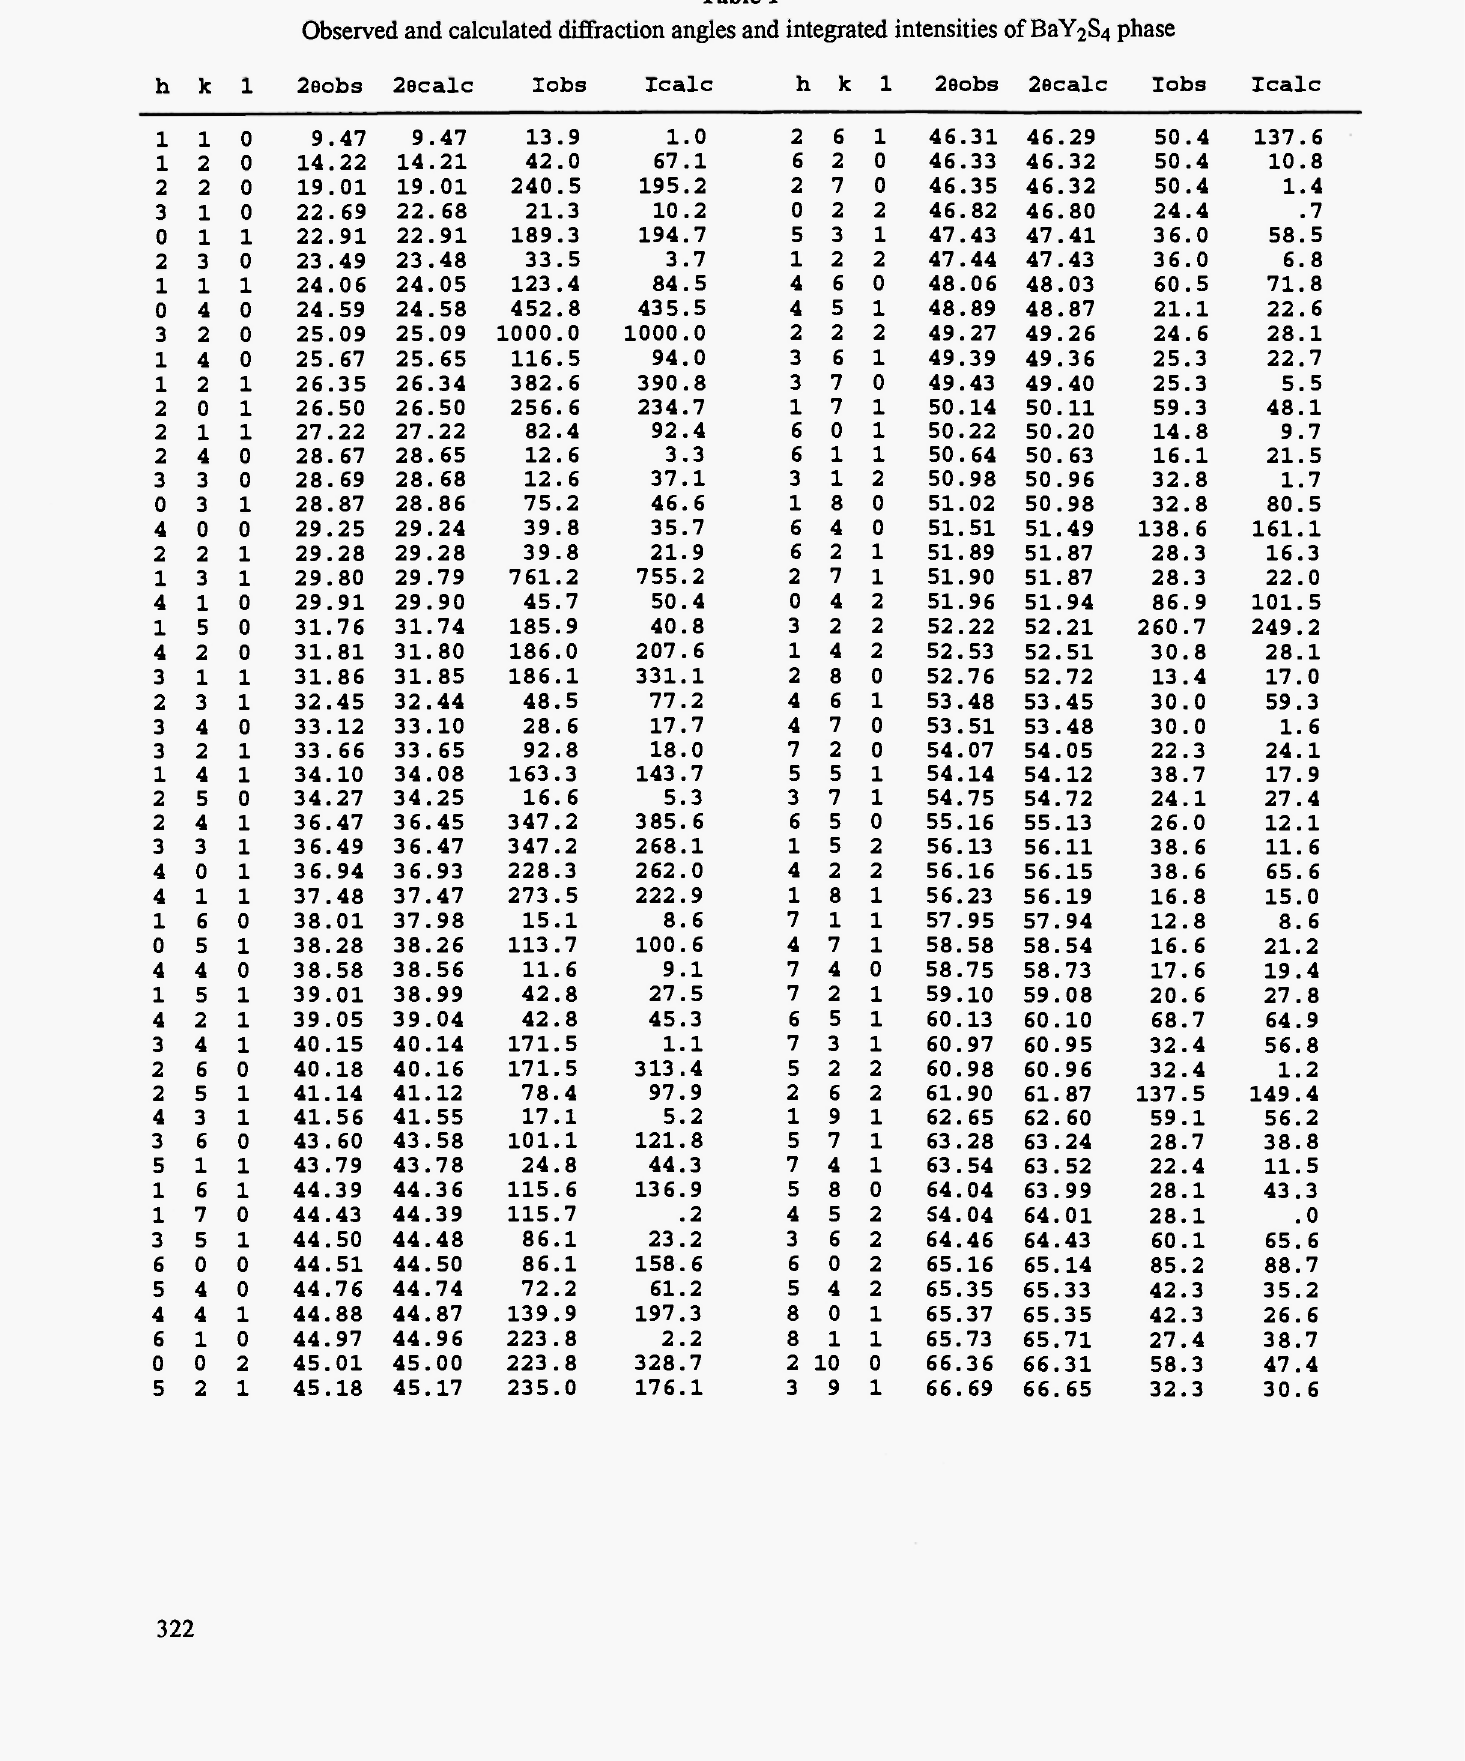
Observed and calculated diffraction angles and integrated intensities of BaY2S 4